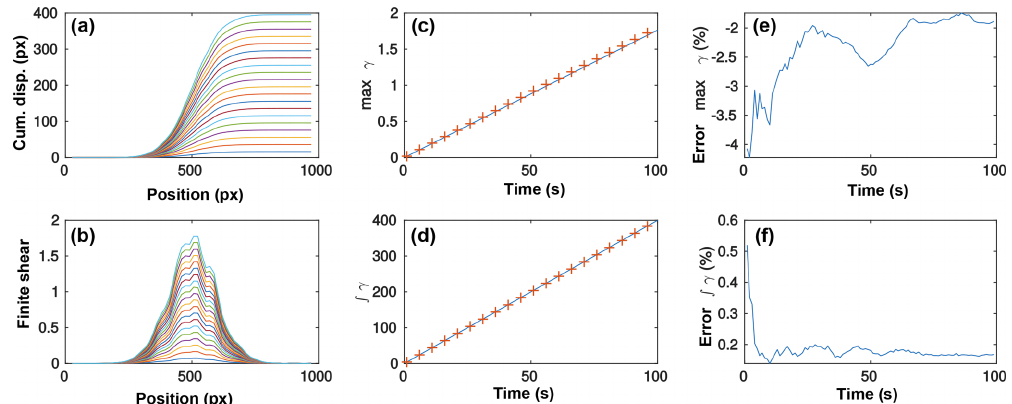
Figure 7. Benchmark of the Eulerian sum of displacements using a synthetic static shear zone. (a) Cumulative displacement profiles across the static shear zone (profile plotted every five frames only for clarity); (b) gradients of the cumulative displacement profiles from panel (a) ; (c) evolution of the peak of the gradient of the cumulative displacements (i.e. maximum shear, γ ) versus time (assuming 1s between frames in synthetic tests) measured from PIV (red crosses) versus the solution (blue line) every five frames; (d) integral of the shear profile versus time measured from PIV (red crosses) and solution (blue line) every five frames; (e) error of the peak cumulative shear strain; (f) error of the integrated cumulative shear